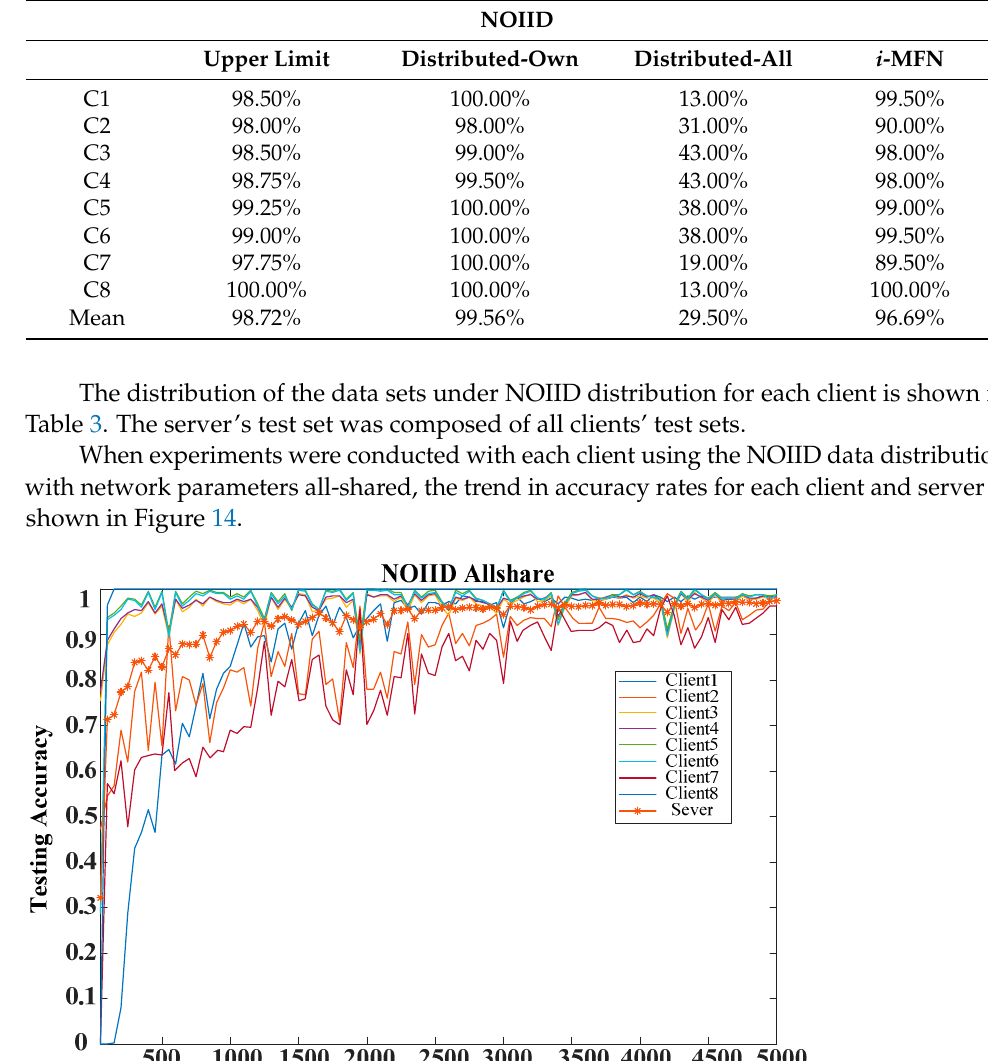
Table 5. Comparison of diagnostic accuracy under NOIID distribution.